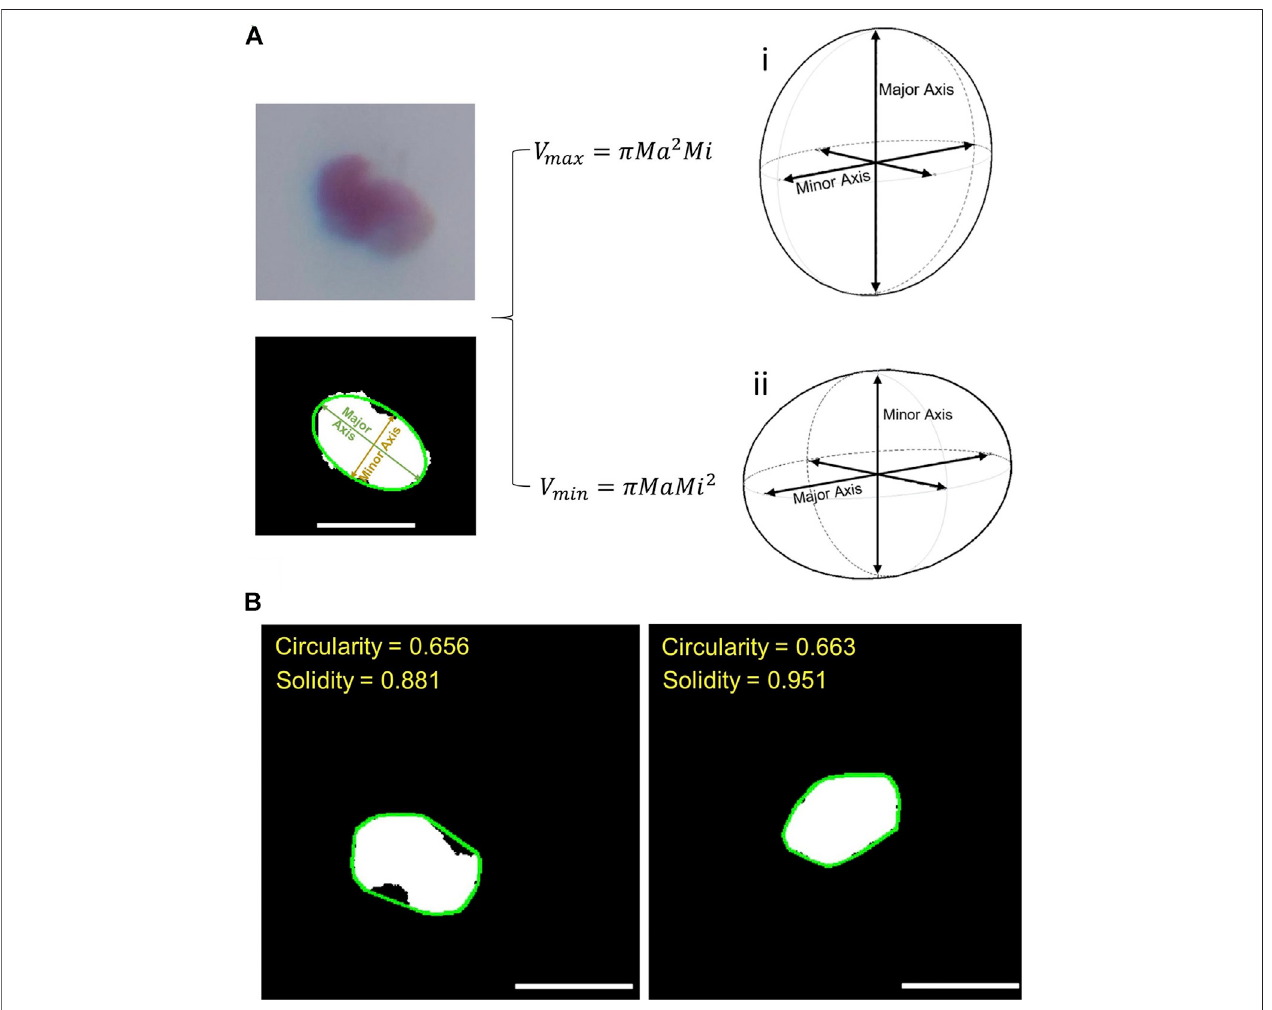
FIGURE 4 | (A) Demonstration of cell volume estimation. The two fi gures on the left show the process of ellipse fi tting. The two fi gures on the right show the two differentmethodsofestimatingvolumeafterellipse fi tting: (i) thecalculationofellipsoidvolumewhenthethirdaxisisthemajoraxis; (ii) thesamecalculationwhenthethird axis is the minor axis. (B) Demonstration of circularity and solidity assessment. The green lines in the two images represent the convex hull for the two islets. Solidity is de fi ned as the ratio between actual cell size (white area) and the area surrounded by the convex hull. Scale bar (cid:1) 200